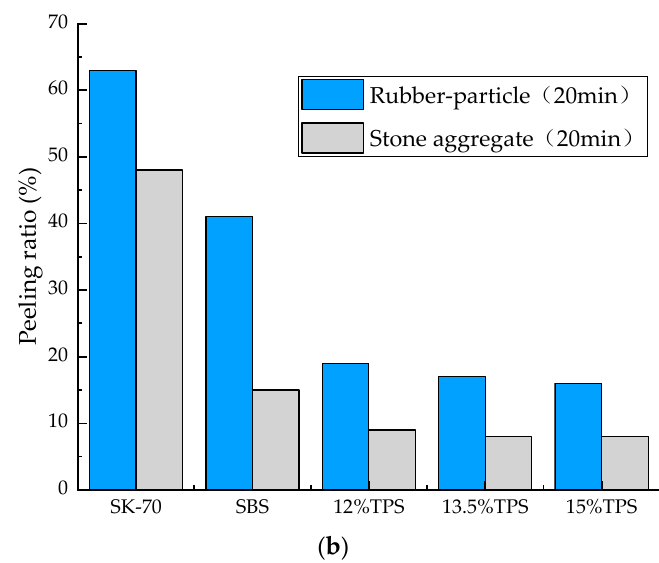
Figure 5. Adhesion test results of aggregate with different asphalt: ( a ) boiled for 10 min; ( b ) boiled for 20 min.